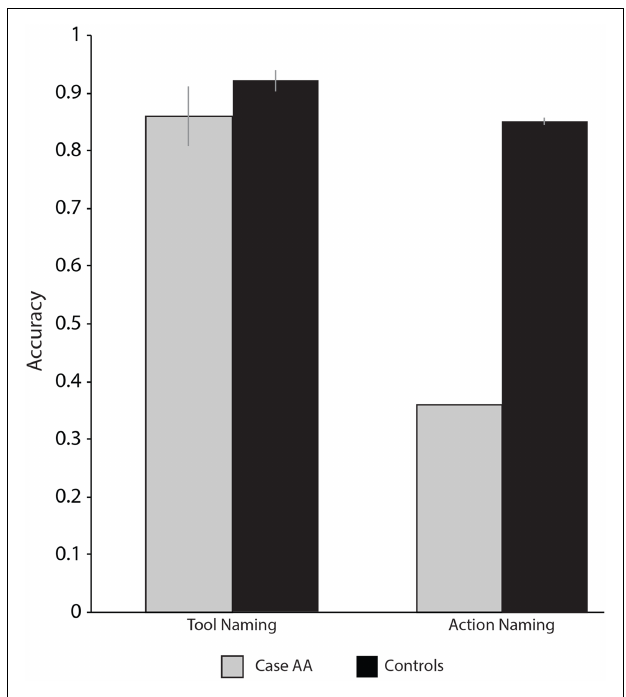
FIGURE 3 | CaseAA and controls’ tool and action naming accuracy.